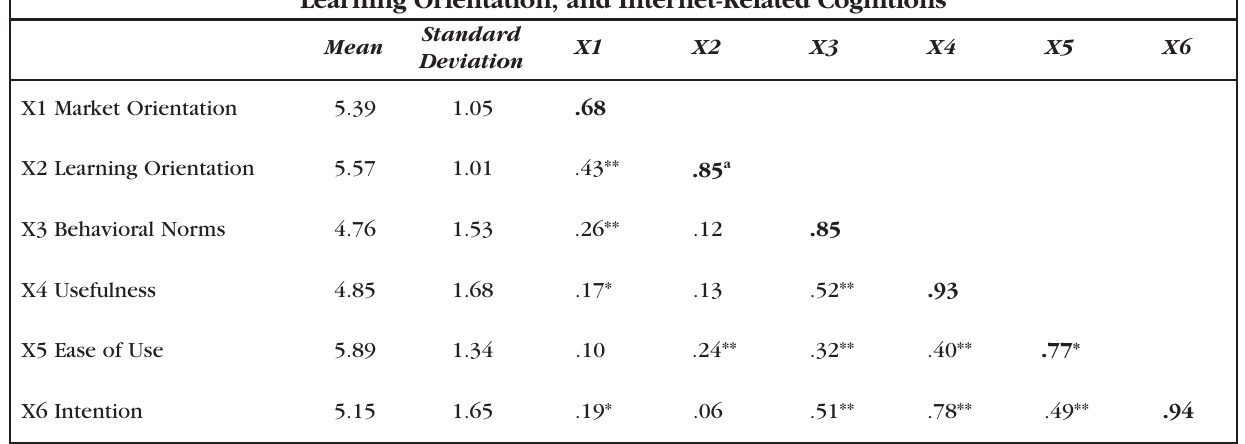
Table 1. Descriptive Statistics, Correlations, and Reliabilities for Marketing Orientation, Learning Orientation, and Internet-Related